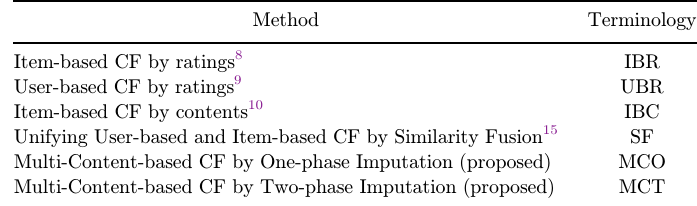
Table 10. Compared